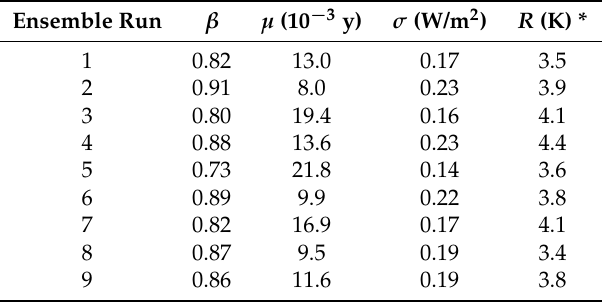
Table 3. A set of parameter estimates for repeated historical runs of the CSIRO model. Ensemble